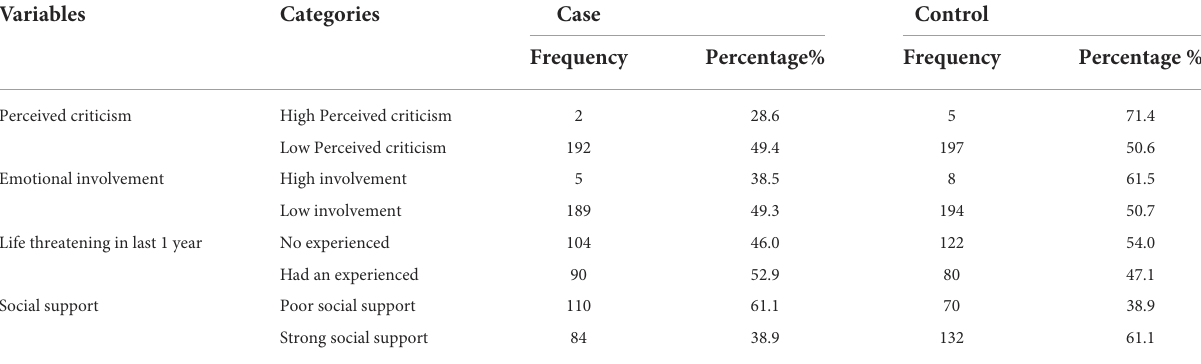
TABLE 3 Psychosocial characteristics of patients with schizophrenia at the Amanuel Mental Specialized Hospital, Addis Ababa, Ethiopia ( n =